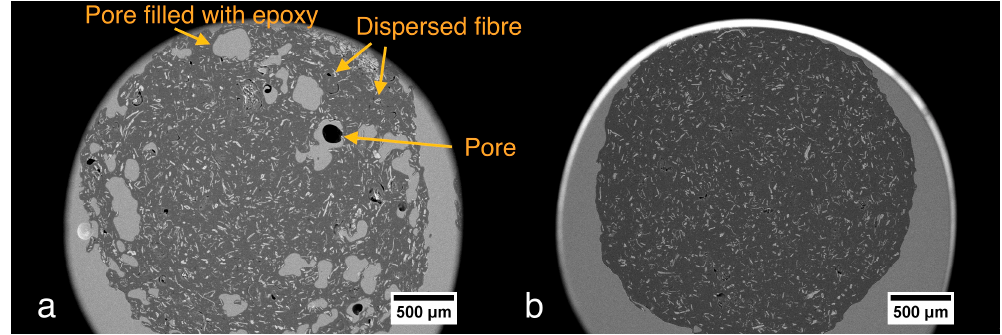
Figure 1. SEM cross-sectional image at 50× magnification. ( a ) B2-OGT20 after one extrusion; ( b ) B2-OGT20 after two extrusions.